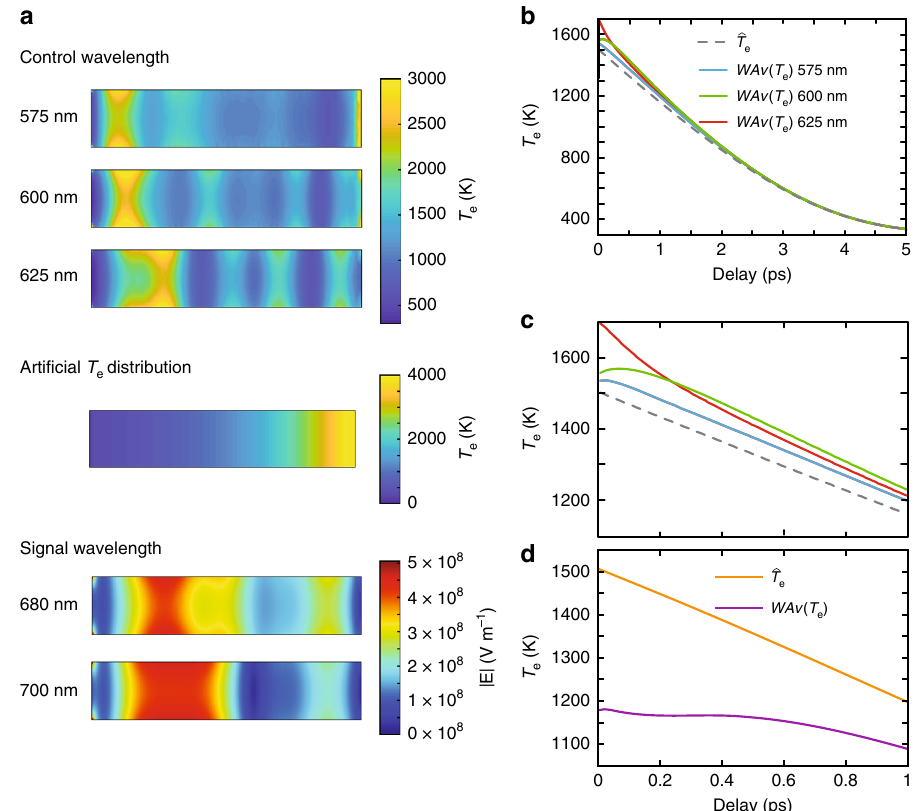
Fig. 4 Evolution of electron temperature distribution in the nanorod metamaterial. a Cross sections of the electron temperature distributions in a unit cell nanorod of length, diameter, and period of 400nm, 30 nm, and 70 nm, respectively. The distribution is induced by simulating control and signal light parameters as in Fig. 2 but with varied wavelengths. The electric fi elds produced in the unit cell structure by 680 nm and 700 nm signal light wavelengths are also shown to visualise the changing overlap between it and the electron temperature distributions. b Simulated electron temperature dynamics for different control wavelengths. The initial volume-average temperature is set to be 1500 K for each temperature distribution generated by the various pump wavelengths. WA ν ( T e ) is then calculated by considering the overlap between the electron temperature distribution and the 680 nm signal mode in a . This is also compared to the homogeneous temperature model b T . c As b during the fi rst ps. d Electron temperature dynamics of the arti fi cial e